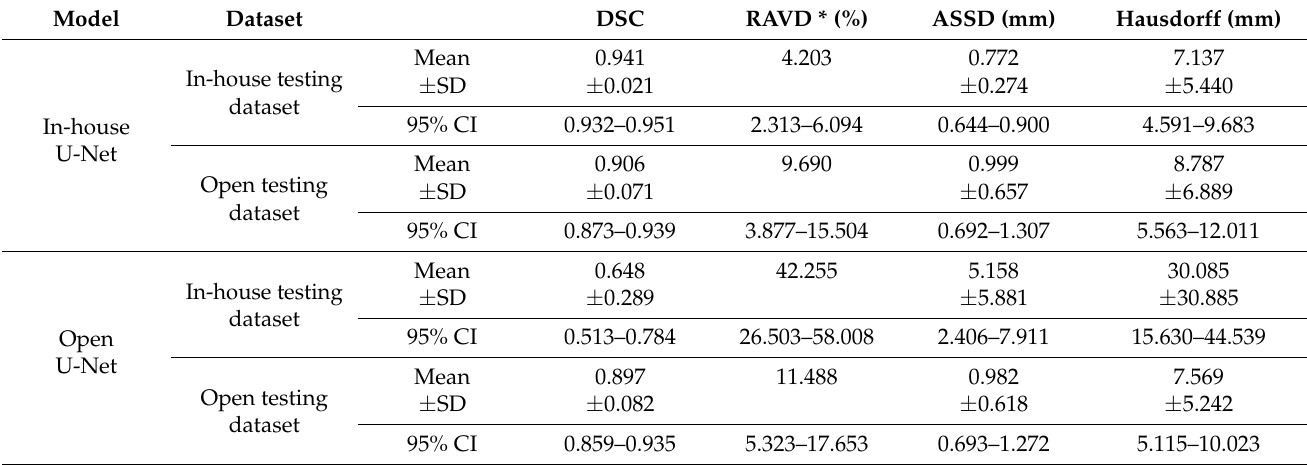
Table 2. Model performances on the in-house and open testing